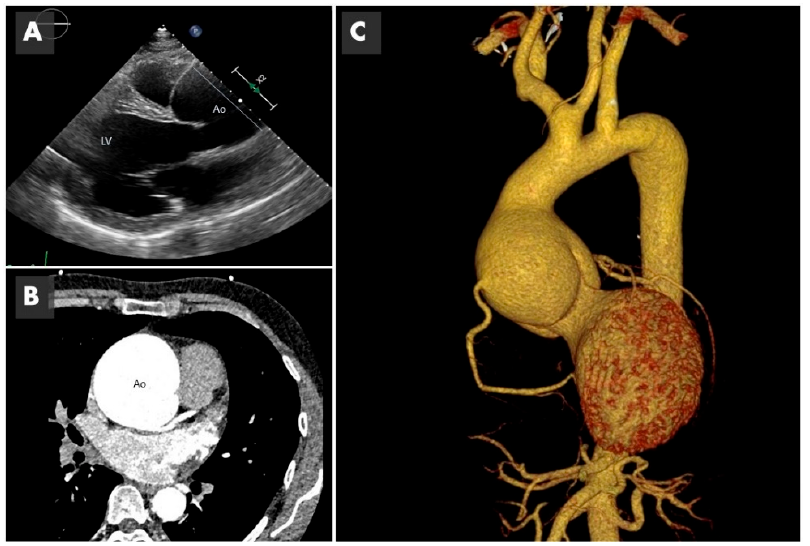
Figure 2. Imaging of bicuspid associated aneurysm. ( A ) The 2D image of a transthoracic echocardiogram in the parasternal long axis plane showing the dilated aorta (Ao) marked with the straight line (LV: left ventricle). ( B ) Computed tomography (CT) in axial plane showing the very dilated ascending aorta (Ao) at the level of the sinuses of Valsalva. ( C ) The 3D CT reconstruction, showing a huge 8 cm aneurysm.